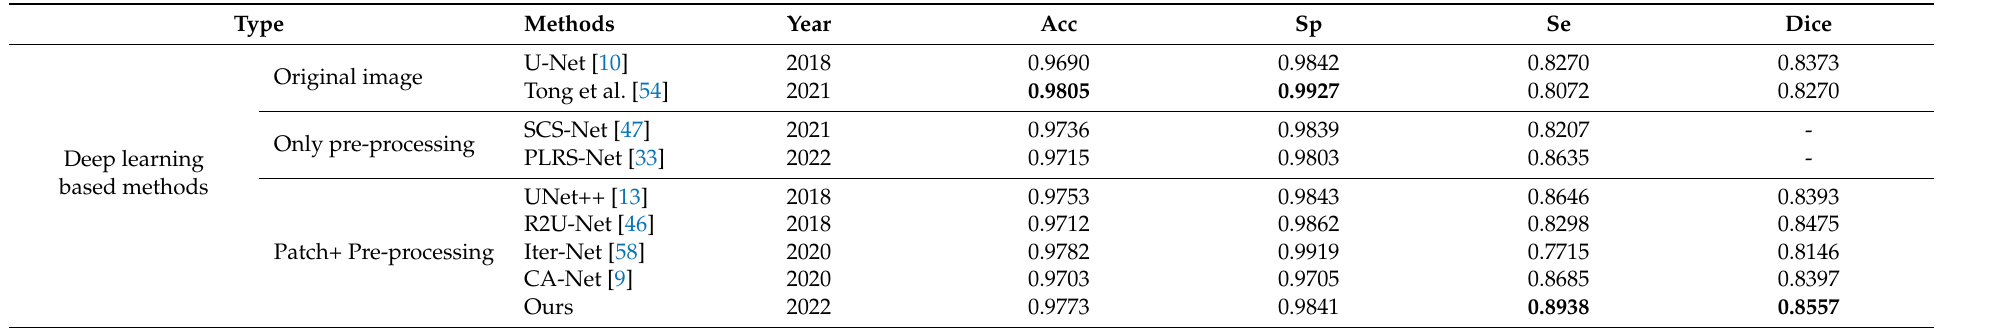
Table 6. Comparison with other methods on the STARE